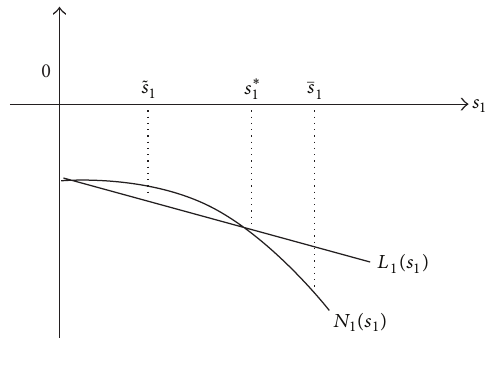
Figure 2: 𝑁 1 (𝑠 1 ) and 𝐿 1 (𝑠 1 ) for 0 ≤ 𝑠 1 ≪ 1 , ] ∈ 𝐻 1 2 ∩ 𝐷 2 .